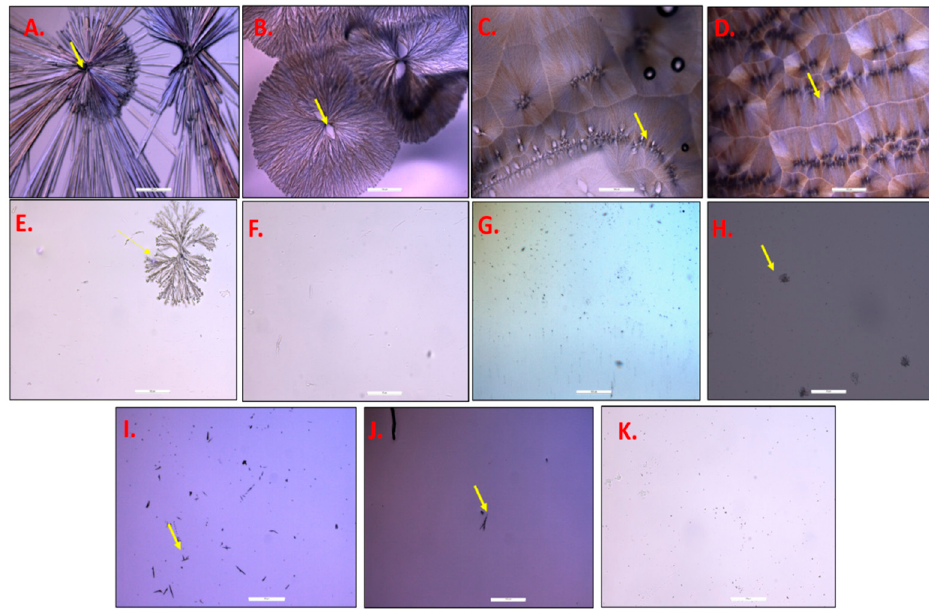
Figure 1. Images of slide crystallization studies, under optical microscope. ( A ). Pure TAF (at 10×). ( B– D ). TAF crystals in DURO-TAK 87-2516 immediately after evaporation of organic solvent at 10×: ( B ) 3% w / w TAF ( C ). 5% w / w TAF ( D ). 12% w / w TAF. ( E ). 2% w / w TAF in DURO-TAK 87-2516, 3 days after evaporation of organic solvent (10×). ( F ). 1% w / w TAF in DURO-TAK 87-2516, 7 days after evaporation of organic solvent (20×). ( G ). 4% w / w TAF in 5% w / w OA in DURO-TAK 87-2516 (10×). ( H ). 5% w / w TAF in 5% w / w OA in DURO-TAK 87-2516 (20×). ( I ). TAF:PVP 360 (9:1) under 20×. ( J ). TAF:PVP 360 (8:2) under 10×. ( K ).TAF:PVP 360 (7:3) under 20× (arrows depicting TAF crystals).